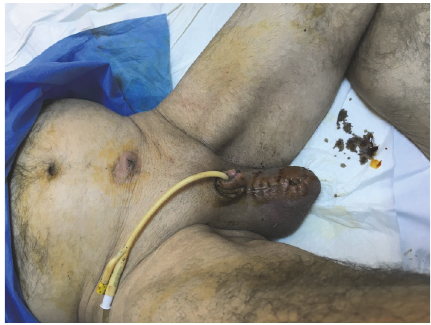
Figure 4: Penis after the closure with skin